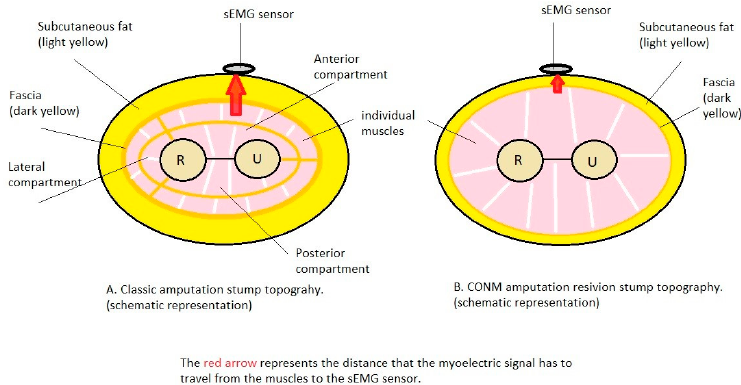
Figure 4. Plot of the mean amplitude values for the sEMG signals before and after the CONM technique blunt revision.